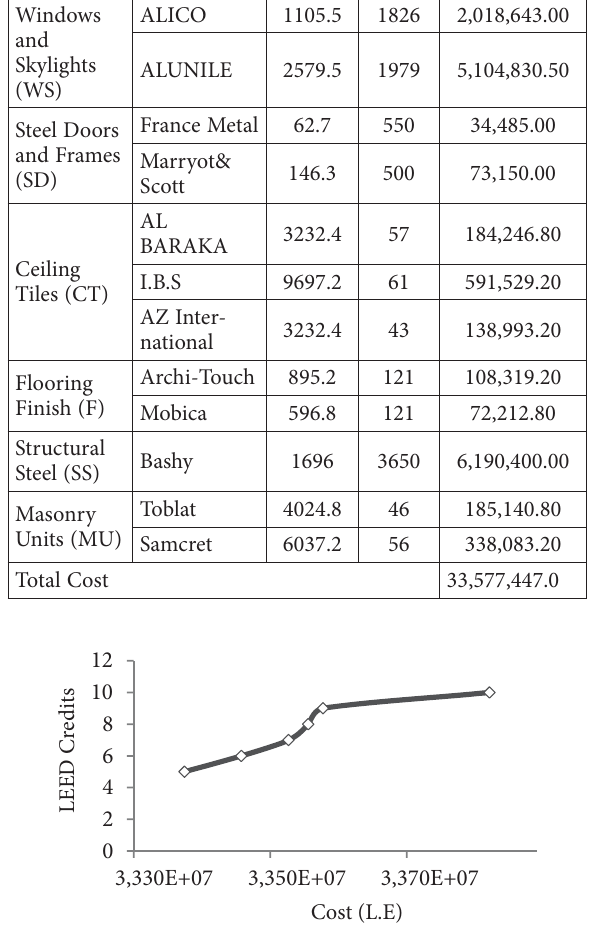
Figure 6. LEED Credits vs.